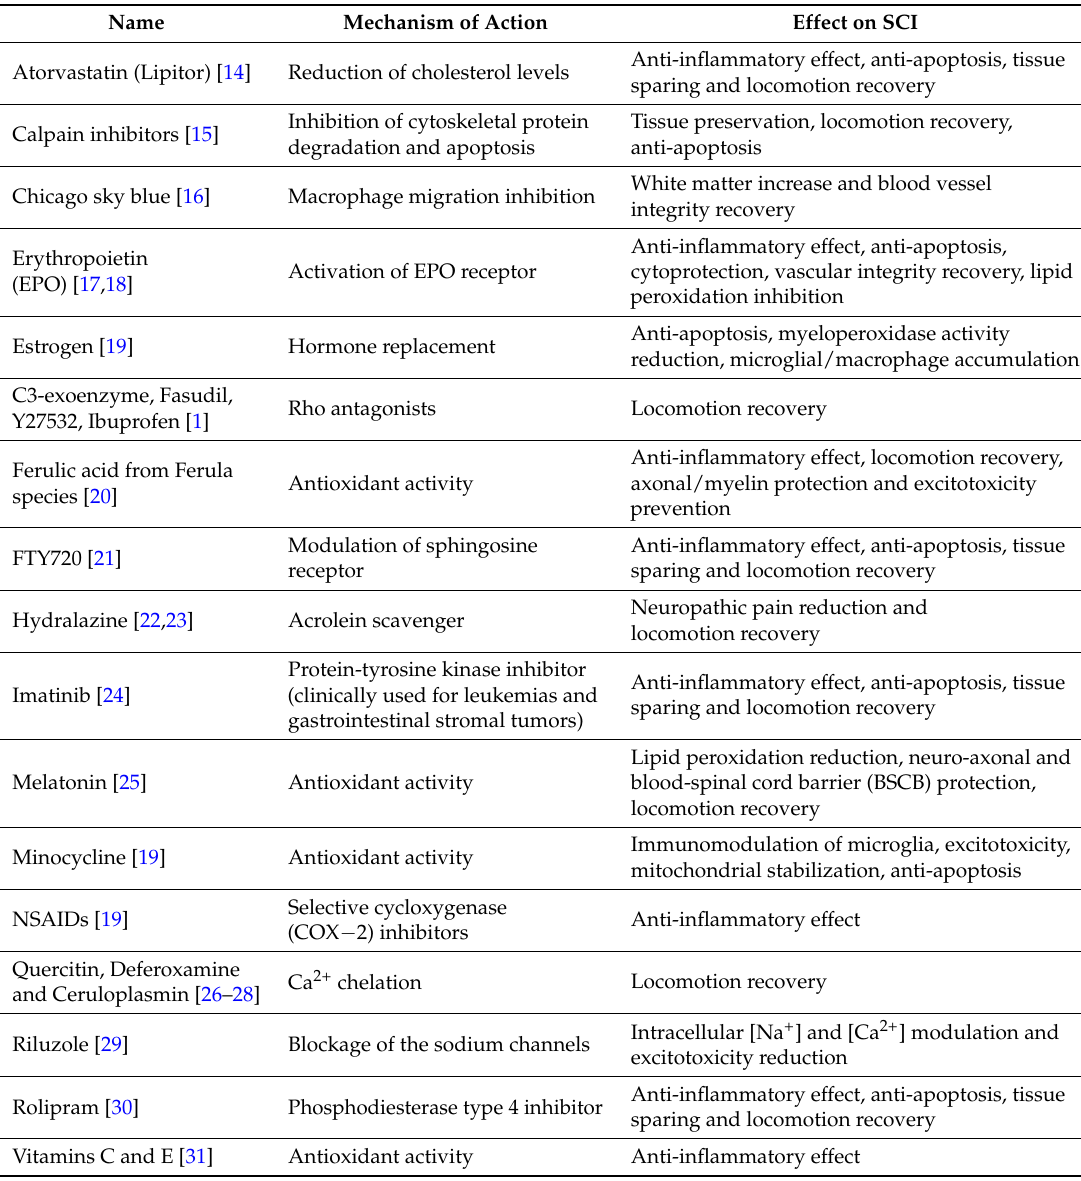
Table 1. Drugs reviewed by Kabu et al. [1] as neuro-protective agents for spinal cord injury (SCI)